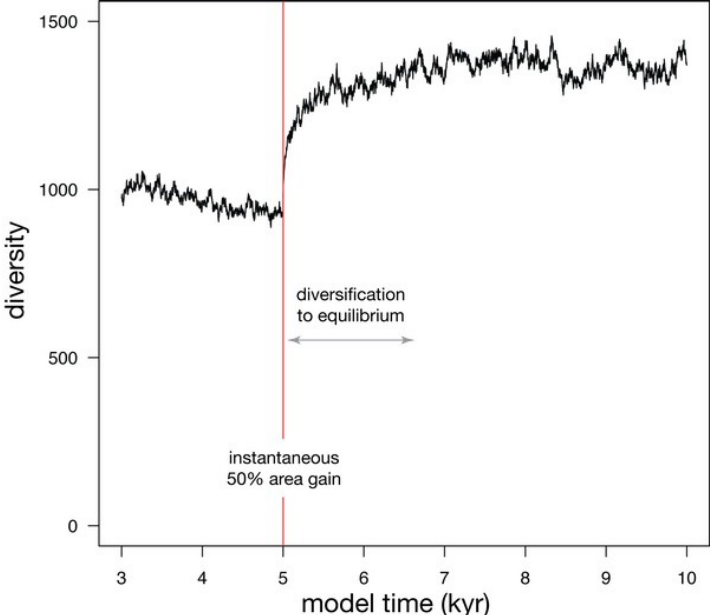
Figure 8. Simulation depicting the change in diversity following an instantaneous 50% gain in habitat area at 5 kyr model